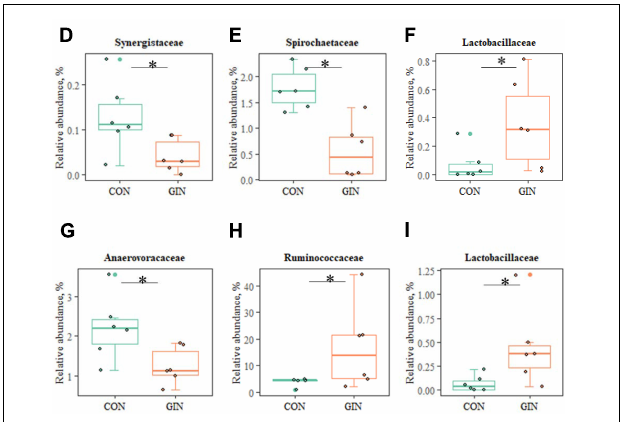
FIGURE 5 | The top 10 families and significantly different families of rumen, abomasum and duodenum. (A–C) The top 10 families of rumen, abomasum and duodenum; (D–F) significantly different families in abomasum; (G–I) significantly different families in duodenum. ∗ P <